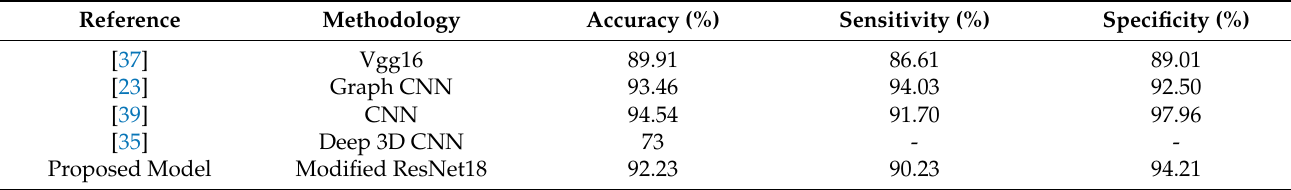
Table 10. Evaluation Results with the CN vs. LMCI Binary Classification.